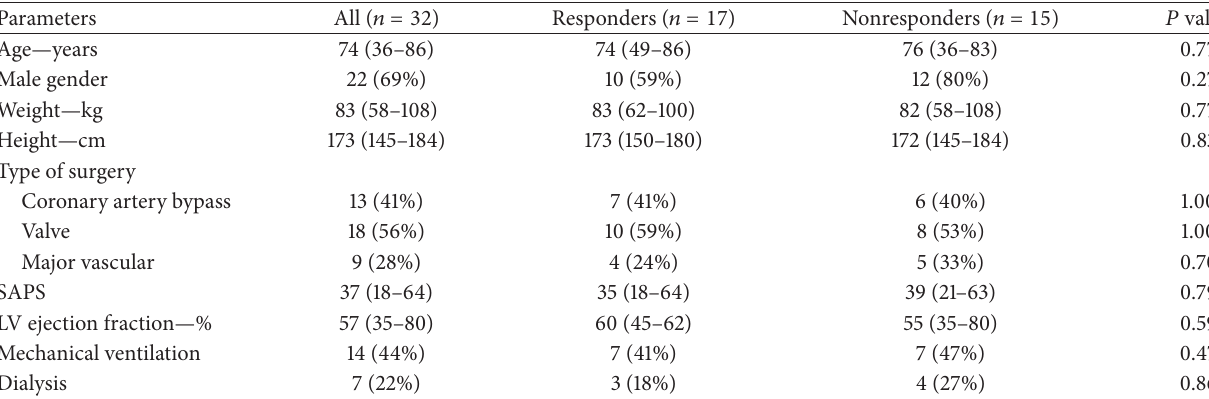
Table 1: Baseline characteristics.